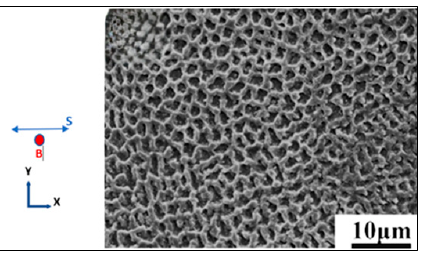
Figure 7. X-Y section (horizontal section) of DLD AM IN625 (adapted with permission from Ref. [23] 2022, Elsevier).